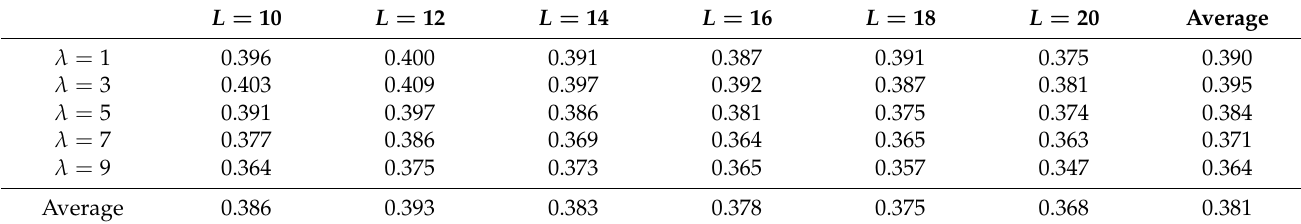
Table 4. Average specificity of the Tl-MVAE for all games when parameters the λ and L of the Poisson distribution are